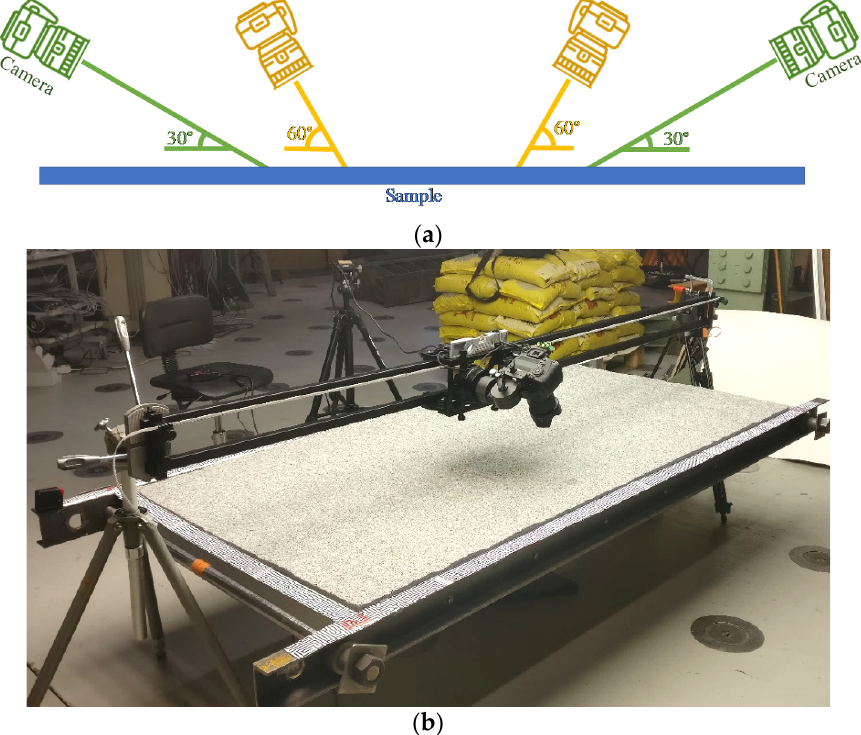
Figure 2. The photogrammetry setup with ( a ) camera positioning in the back-and-forth photograph- ing direction, ( b ) the slider track setup.